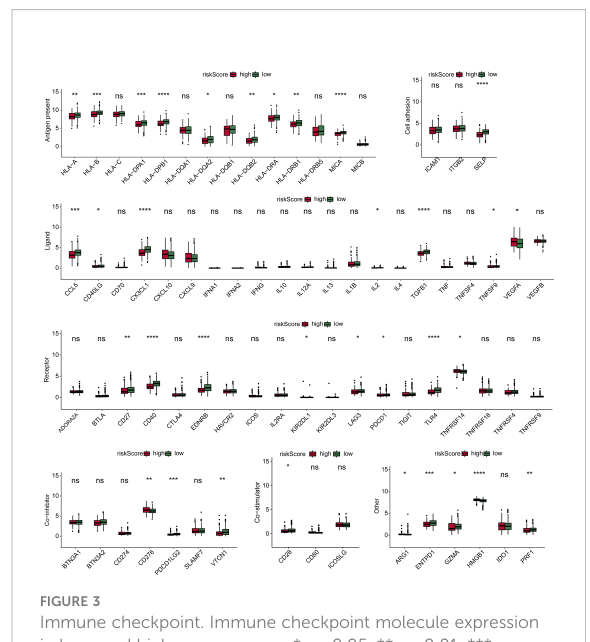
FIGURE 3 Immune checkpoint. Immune checkpoint molecule expression in low- and high-score groups. *p < 0.05. **p < 0.01. ***p < 0.001 ****p < 0.0001. ns, not signi fi